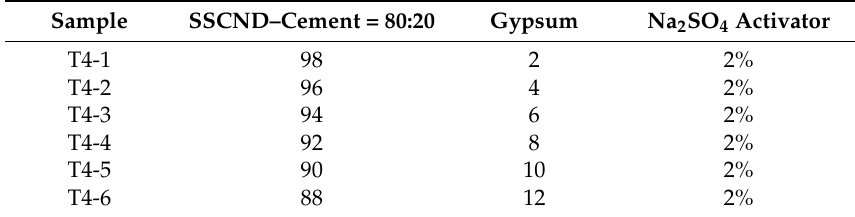
Table 5. Proportion of Na 2 SO 4 and gypsum content (wt